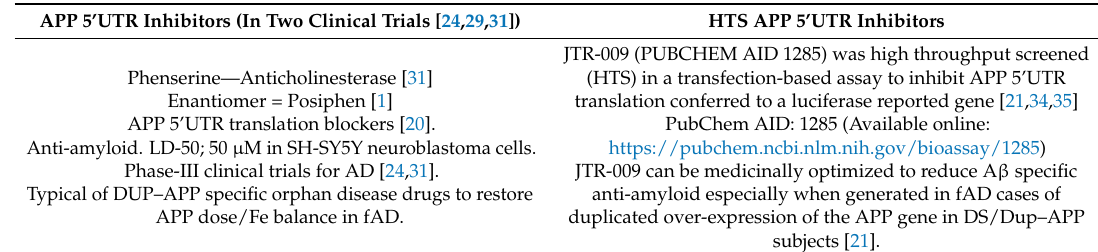
Table 1. Small molecules that inhibit APP translation as an anti-amyloid strategy. Therapeutic potential of clinical and high throughput screened (HTS) translation inhibitors of APP mRNA which may be found to impact on amyloid burden in cortical neurons and mouse models of familial Alzheimer’s disease and Down syndrome [21]. Left panel: The anti-cholinesterase phenserine and its enantiomer posiphen are proven APP 5’UTR inhibitors [1]. Right panel: Top high throughput screened (HTS) 5’UTR directed drug APP blocker 9 (JTR-009) inhibited APP translation